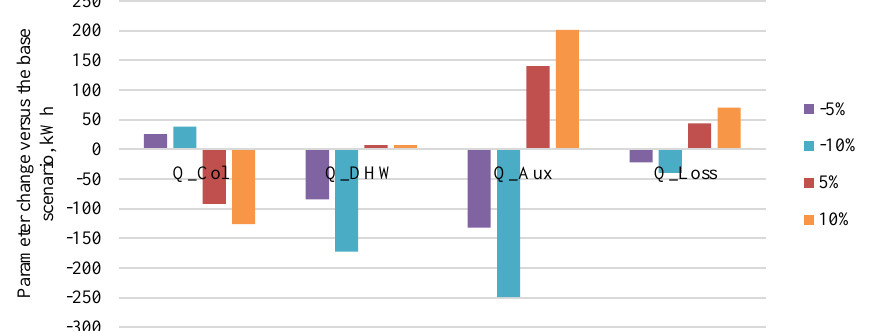
Fig. 8. Heater setpoint change impact on